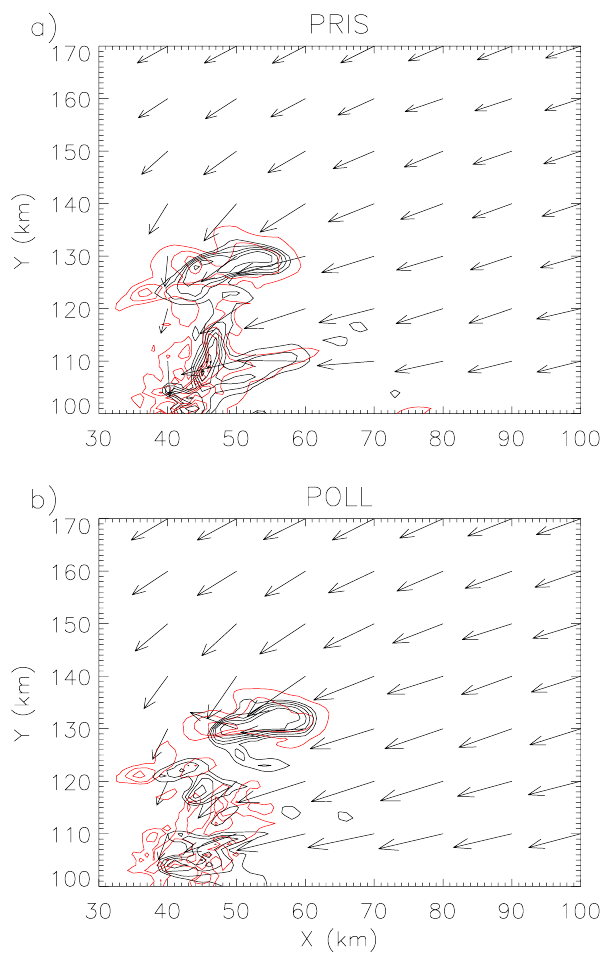
Fig. 10. As in Fig. 8, except for the model configuration with cool- ing by rain evaporation turned off